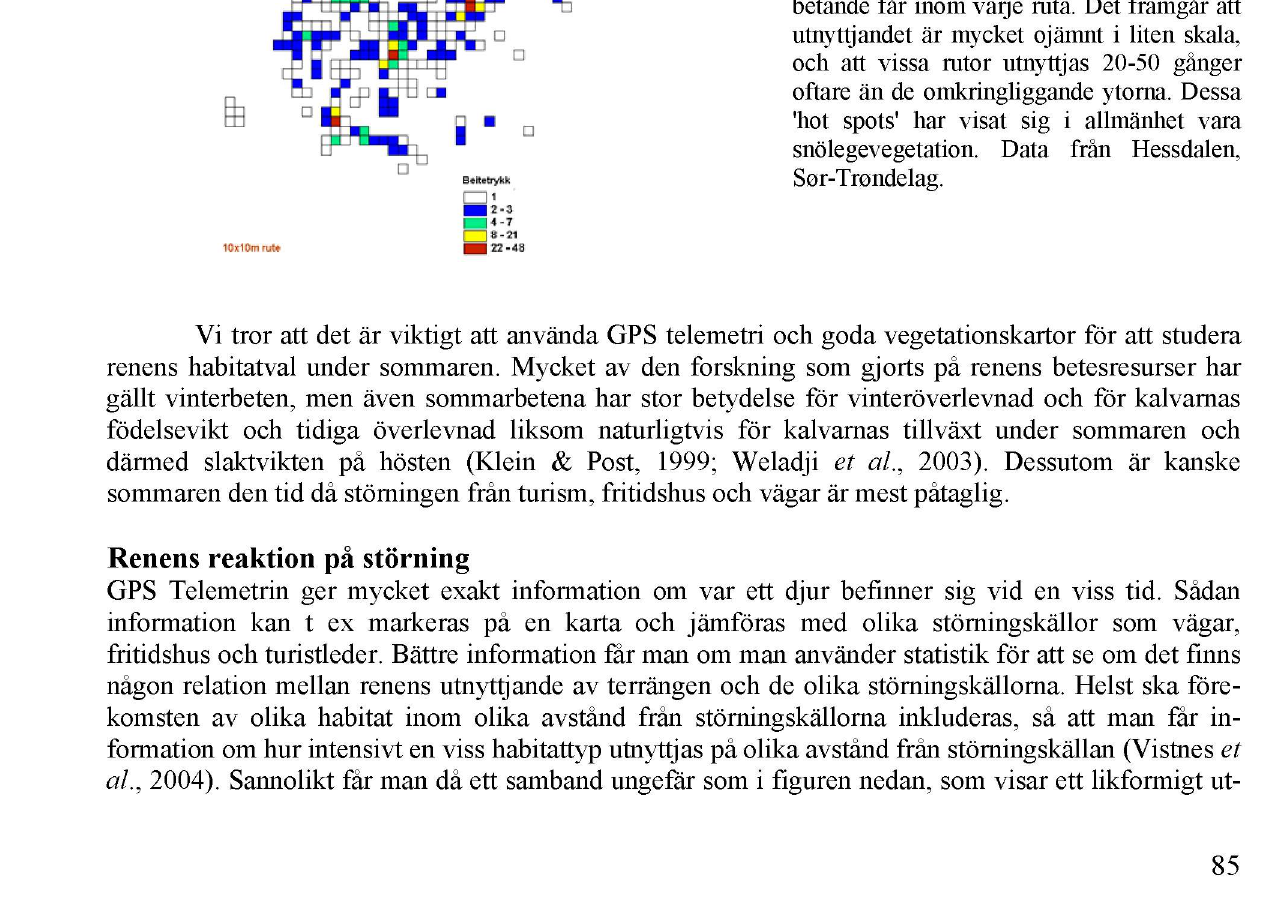
Fig. 2. Utsnitt ur karta som visar habitatutnyttjande av får i fjållet Rutorna år 10 m x 10 m, och fårgkodningen visar antal positioner for betande får inom varje ruta. Det framgår att utnyttjandet år mycket ojåmnt i liten skala, och att vissa rutor utnyttjas 20-50 gånger oftare ån de omkringliggande ytorna. Dessa 'hot spots' har visat sig i allmånhet vara snolegevegetation. Data från Hessdalen,